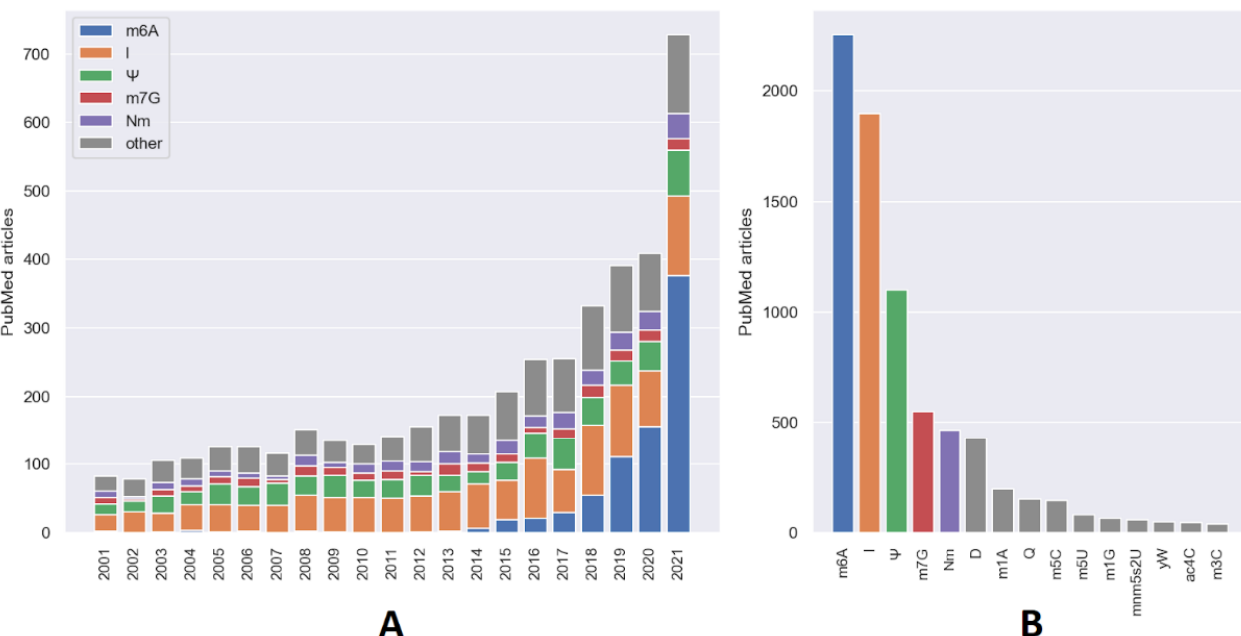
Figure 1. ( A ) Number of published articles that are strongly related to specific RNA modifications in the PubMed database per year. ( B ) Total number of articles on specific RNA modifications in the PubMed database.